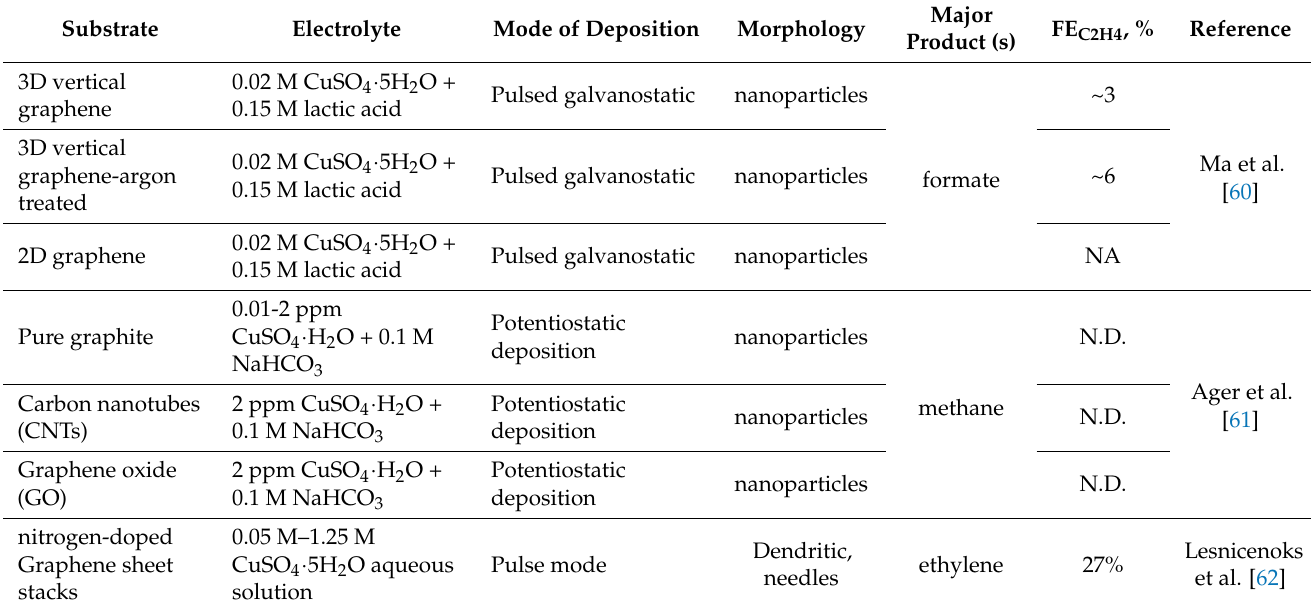
Table 3. Works reported on the electrodeposition of copper obtained on different composite- based